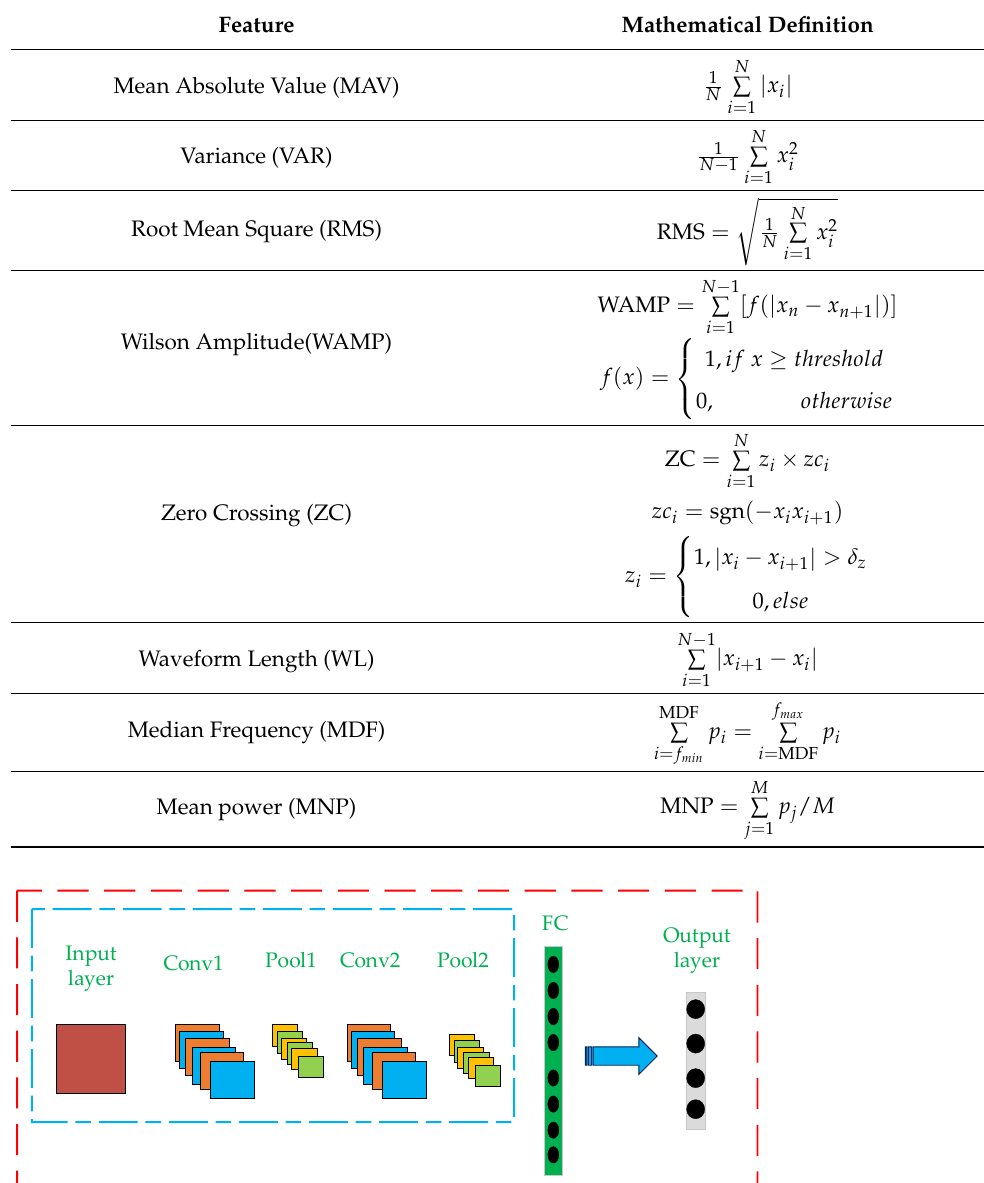
Table 3. Time and frequency domain features expression of EMG.